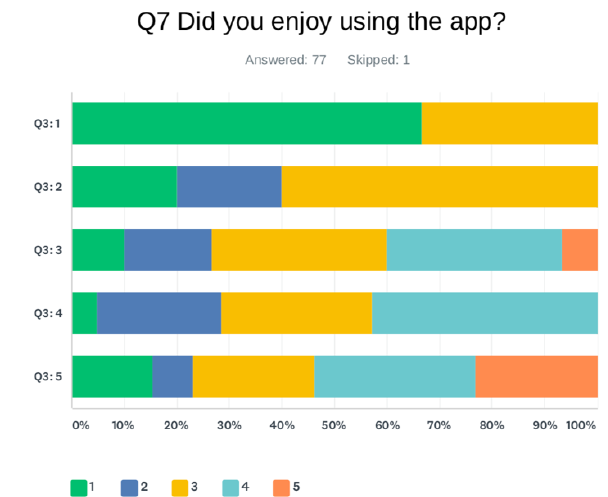
Figure 9. Question 7 split by scores to “Q3. How skilled do you think you are at